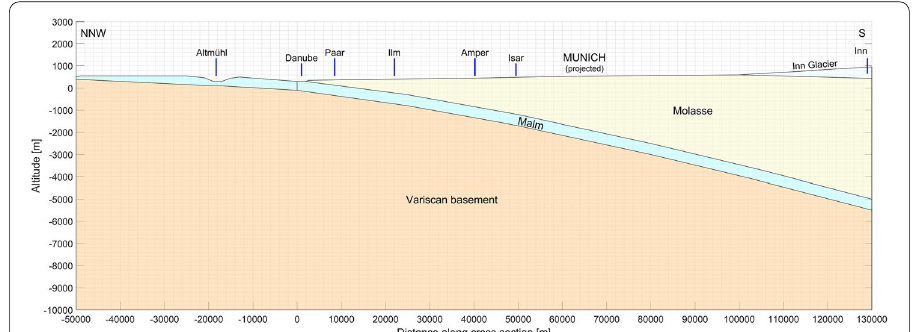
Fig. 4 Generic model geometry representing the simplified Molasse Basin geology along cross section AA’ shown in Fig. 1. It spans from the Franconian Alb in the north (left) over Ingolstadt to the Inn valley (near Rosenheim close to the Alpine Front) in the south (right). Vertical exaggeration equals